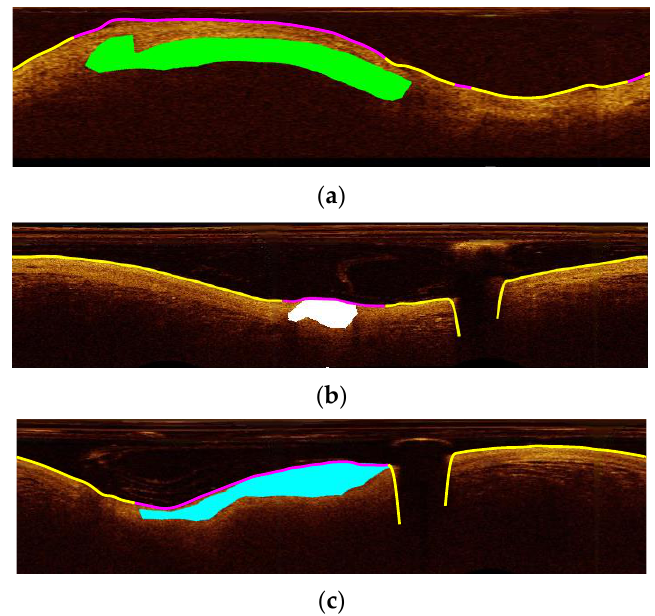
Figure 7. Detection of the atherosclerotic plaque position (purple line) in the ( a – c ) images for three different plaque types. ( a ) mixed plaque (green area as labeled by the manual segmentation), ( b ) calcified plaque (white area), and ( c ) fibrous plaque (blue area). Yellow line in ( a – c ) images shows the detected as normal parts of the arterial wall (lumen border position). In the three images the purple line shows the position of the atherosclerotic plaque in high agreement with the manual segmentation.